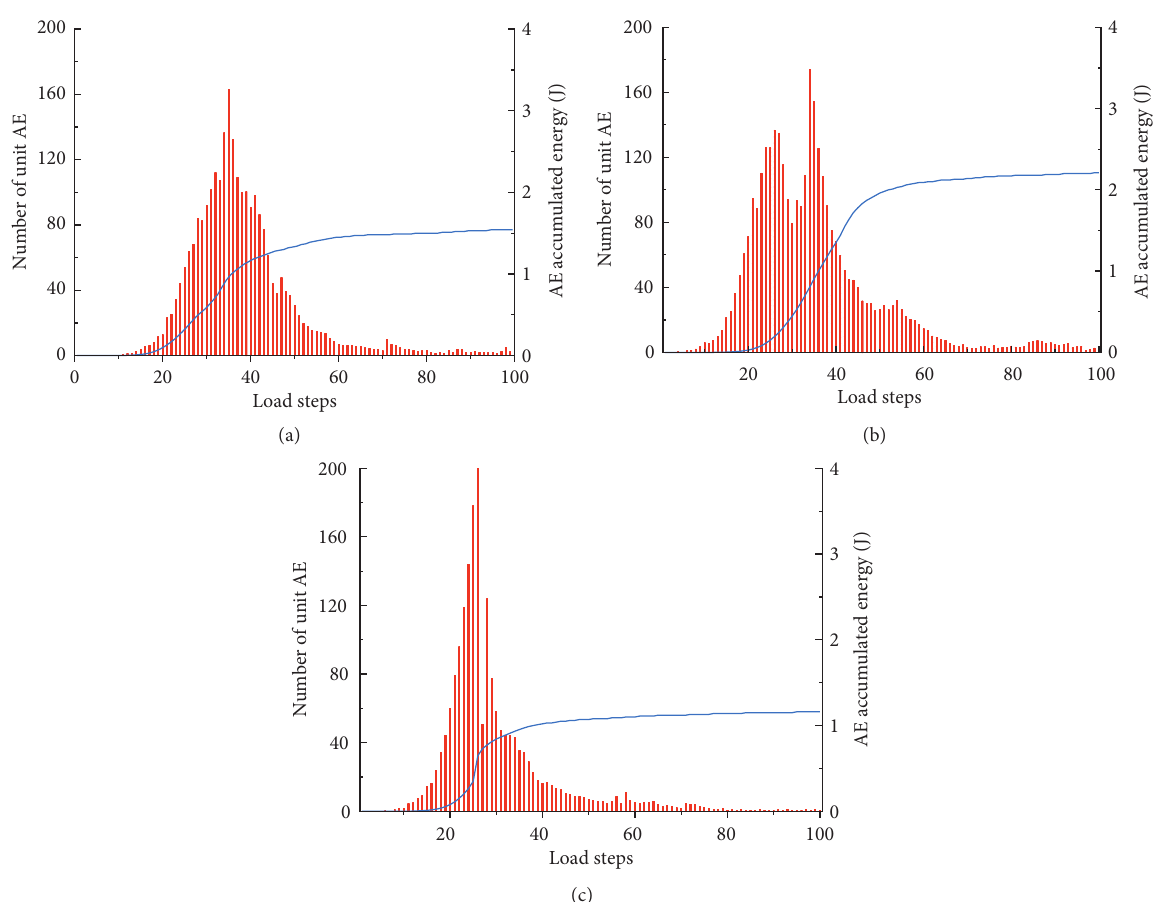
Figure 8: Number of unit acoustic emissions and energy characteristics of the numerical models under static load. (a) Model I; (b) model II; and (c) model III.